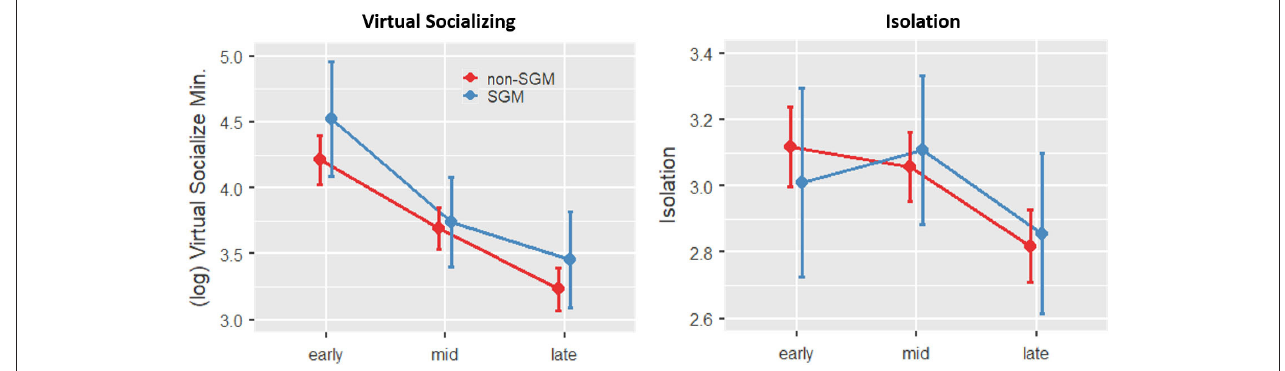
FIGURE 3 | Changes in social engagement and reported feelings of isolation across time and groups (Models 2 and 3). Error bars show 95% confidence intervals. SGM and non-SGM reported similar patterns of progressively decreasing engagement in virtual socializing across the three time points, corresponding to reduced feelings of isolation specifically at the final time